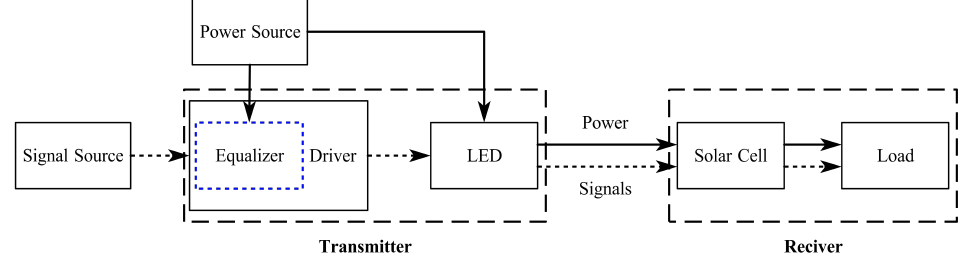
Figure 1. Block diagram of zero-power-consumption visible light communication